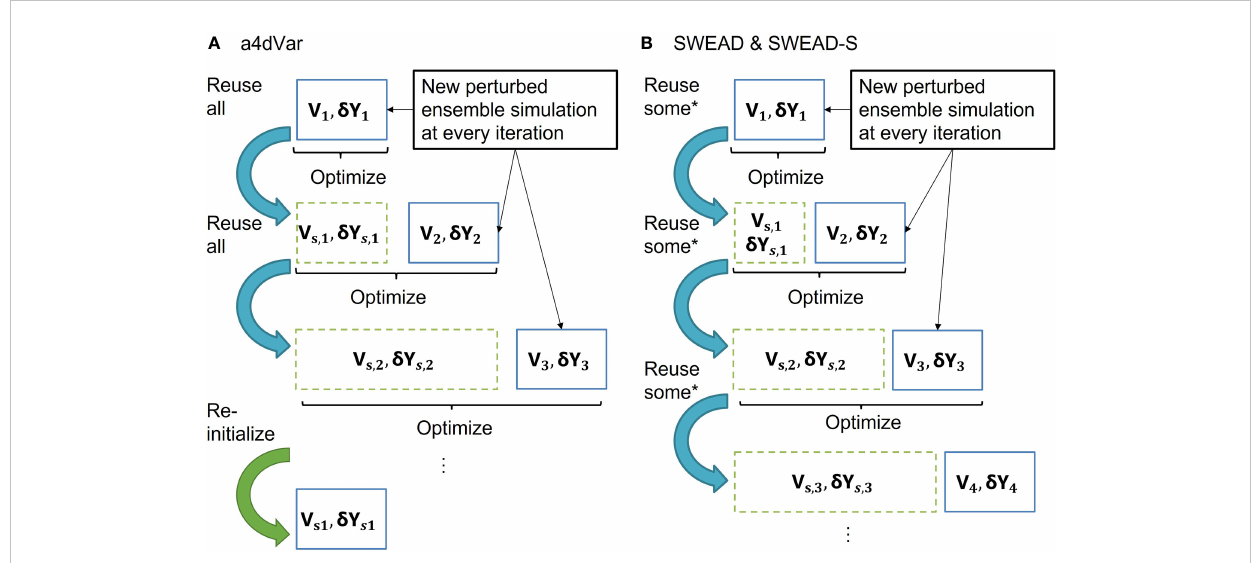
FIGURE 1 Schematic illustration of stacking algorithm for (A) a4dVar and (B) SWEAD and SWEAD-S. This fi gure is a modi fi cation of Fujimoto and Waseda (2020). © American Meteorological Society. Used with permission.